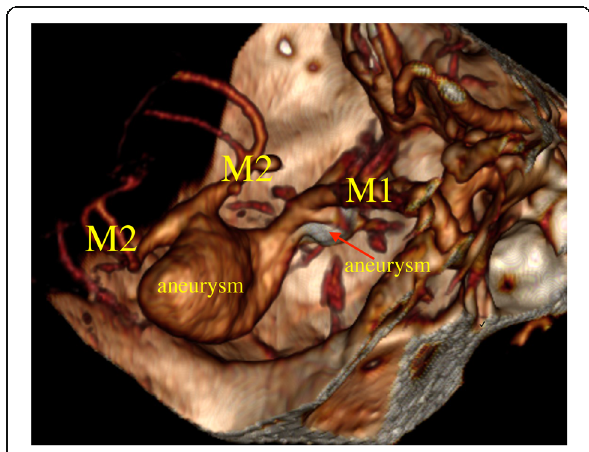
Fig. 2 CT angiography showed a fusiform aneurysm in M1 segment of the right MCA